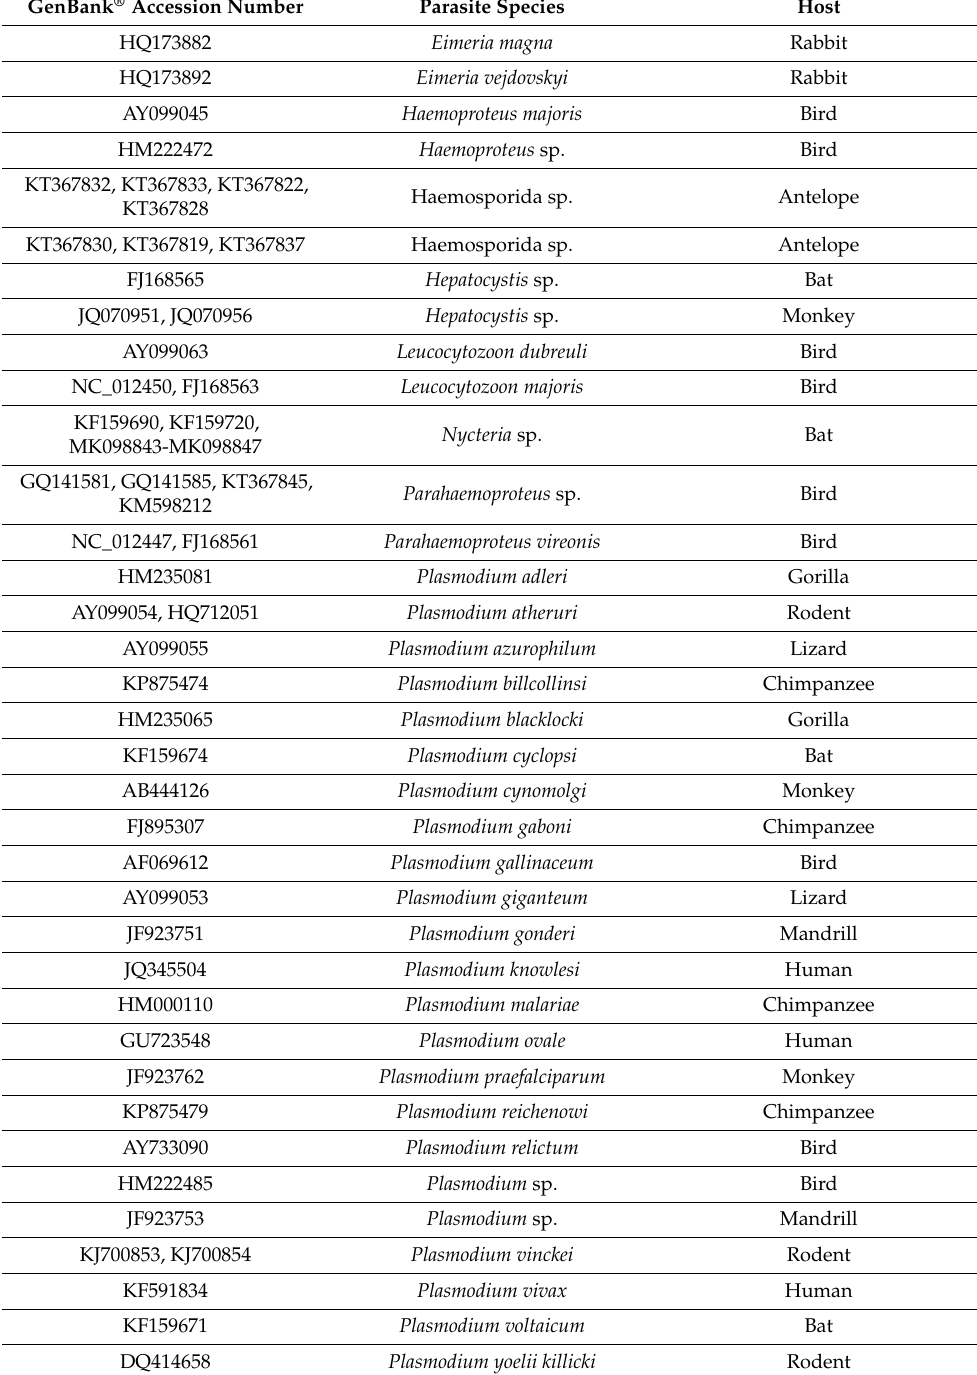
Table A1. Mitochondrial cytochrome b gene ( cytb ) sequences of the parasite used as references for phylogenetic analyses and their respective accession numbers in the Genbank ®